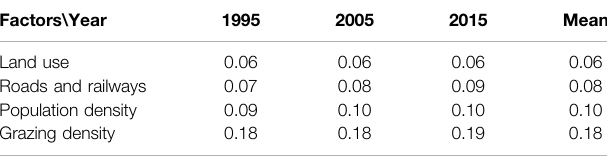
TABLE 3 | The mean values of four individual human activity intensity datasets in 1995, 2005, and 2015 on the Qinghai – Tibet